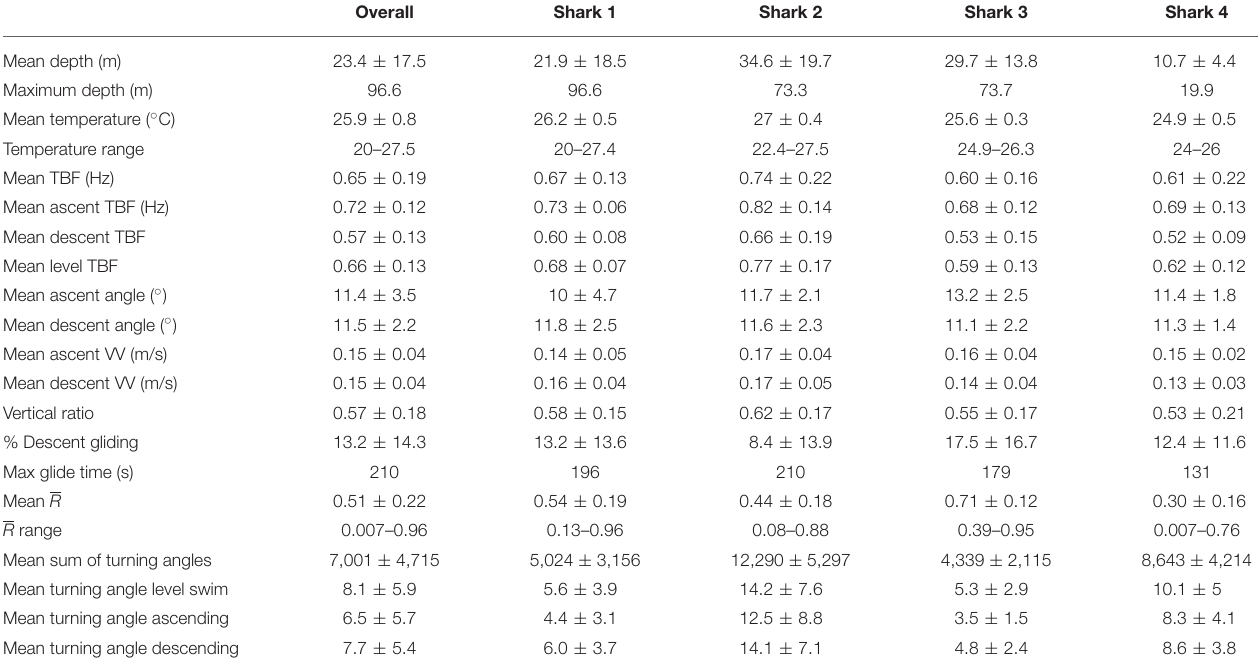
TABLE 3 | Summary statistics calculated for the entire dataset, and each tagged individual.